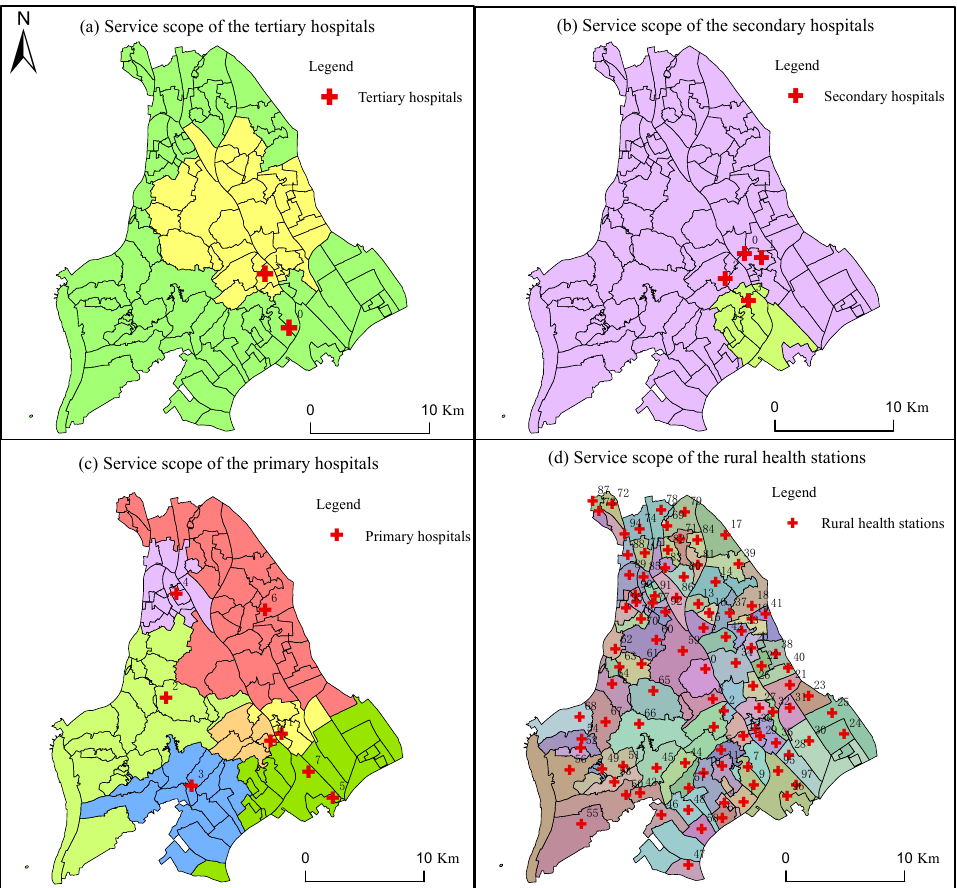
Figure 4. Zoning map of the service scope of multilevel public health facilities in Doumen District, of Zhuhai (Guangdong Province), China, 2020. ( a ) Service scope of the tertiary hospitals. ( b ) Service scope of the secondary hospitals. ( c ) Service scope of the primary hospitals. ( d ) Service scope of the rural health